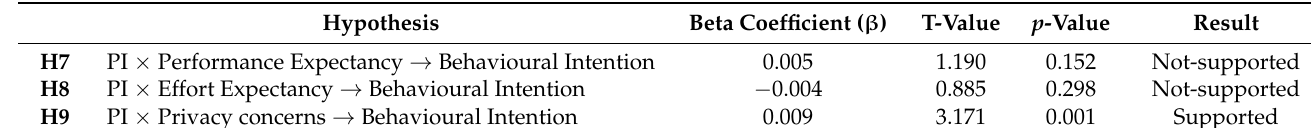
Table 6. Moderating effect of personal innovativeness.